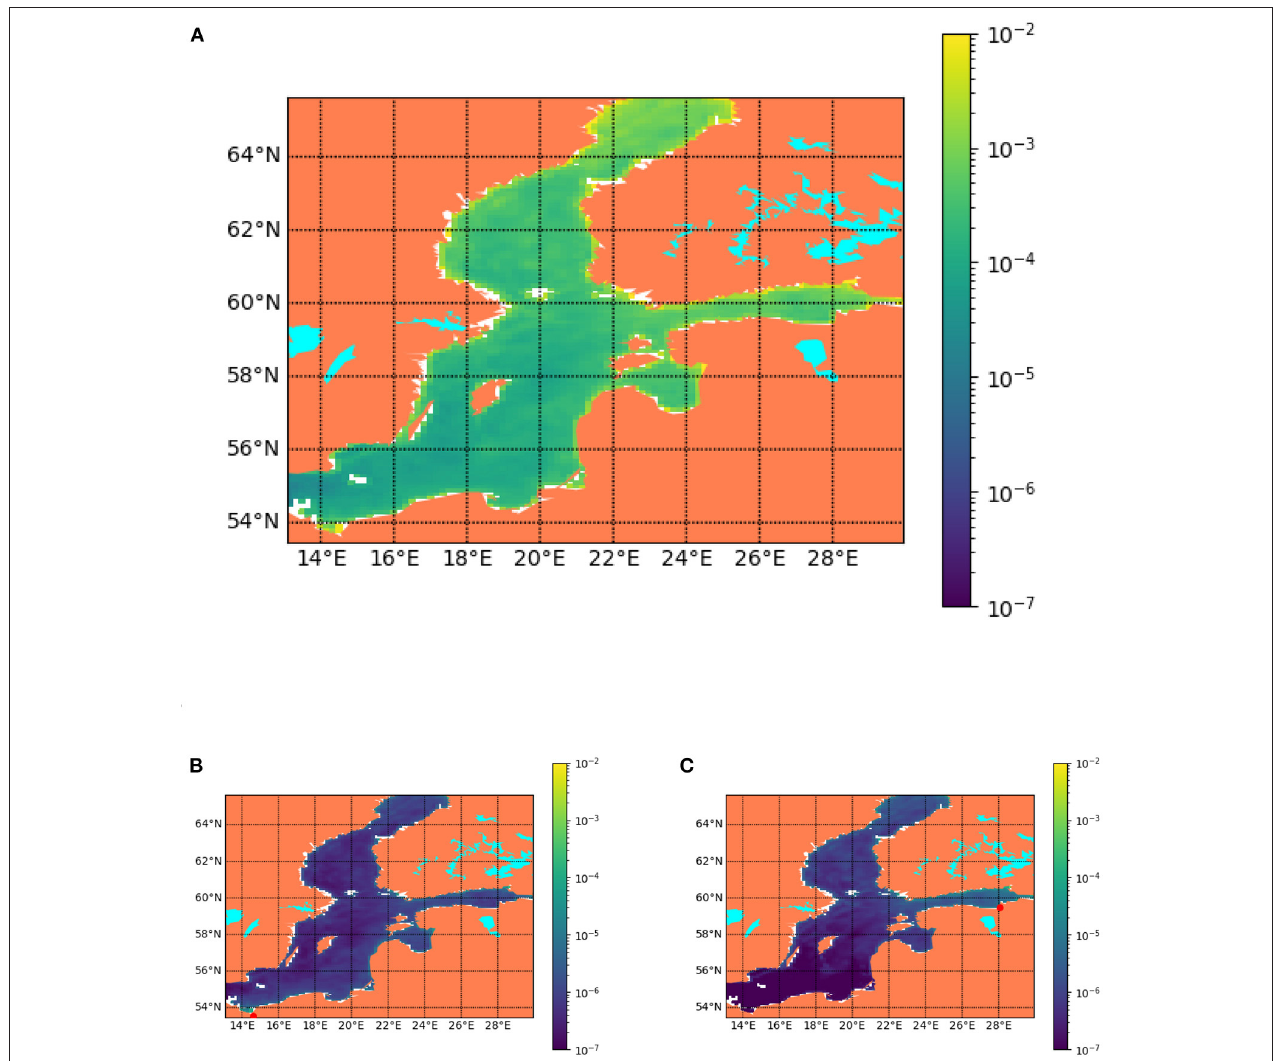
FIGURE 6 | (A) Average macro plastic concentration in the Baltic Sea (tons/km 2 ), corresponding to inputs from all 402 larger river sources and coast litter sources. Macro plastic Green’s functions (year/km 2 ) for (B) river Oder and (C) river Narva, corresponding to unit influx S. River mouths indicated by red circle. All distributions are generated as 4 year averages with 1 spin-up year using the DRRS equilibration